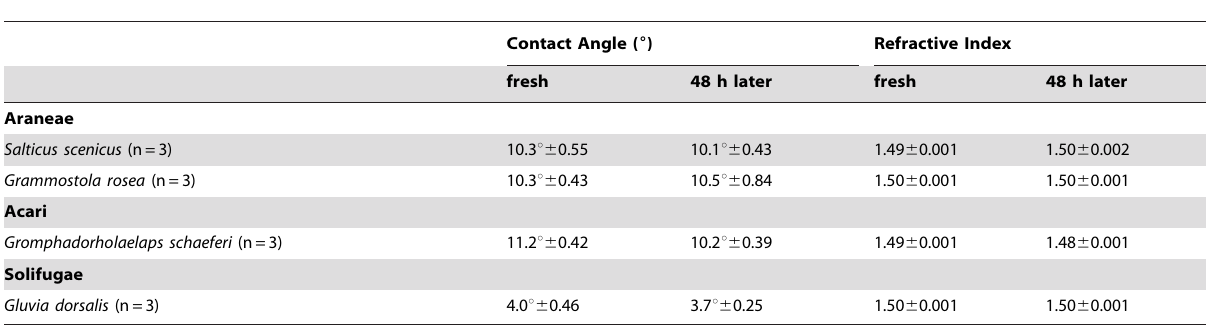
Table 1. Properties of arachnid footprint fluids from four species (mean 6